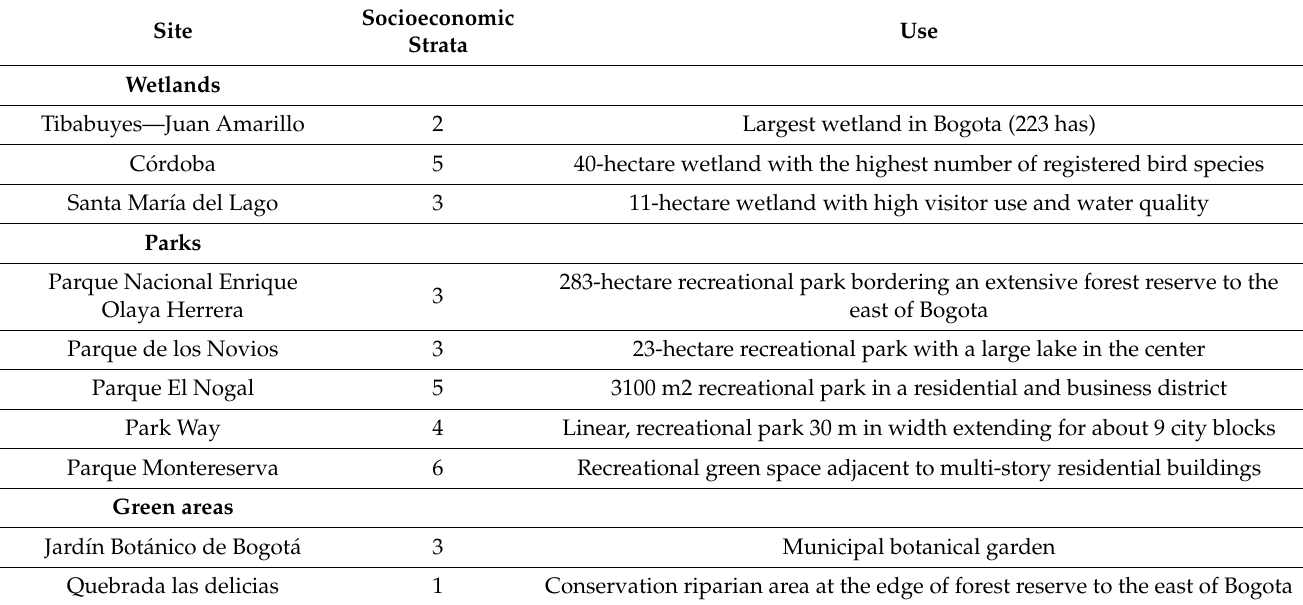
Figure 1. The El Salitre urban sub-watershed in Bogota, Colombia, and its socioeconomic strata and ten sample sites. Table 1. Ten different sites characterizing three different green area types in the urban sub-watershed of El Salitre, Bogota Colombia.